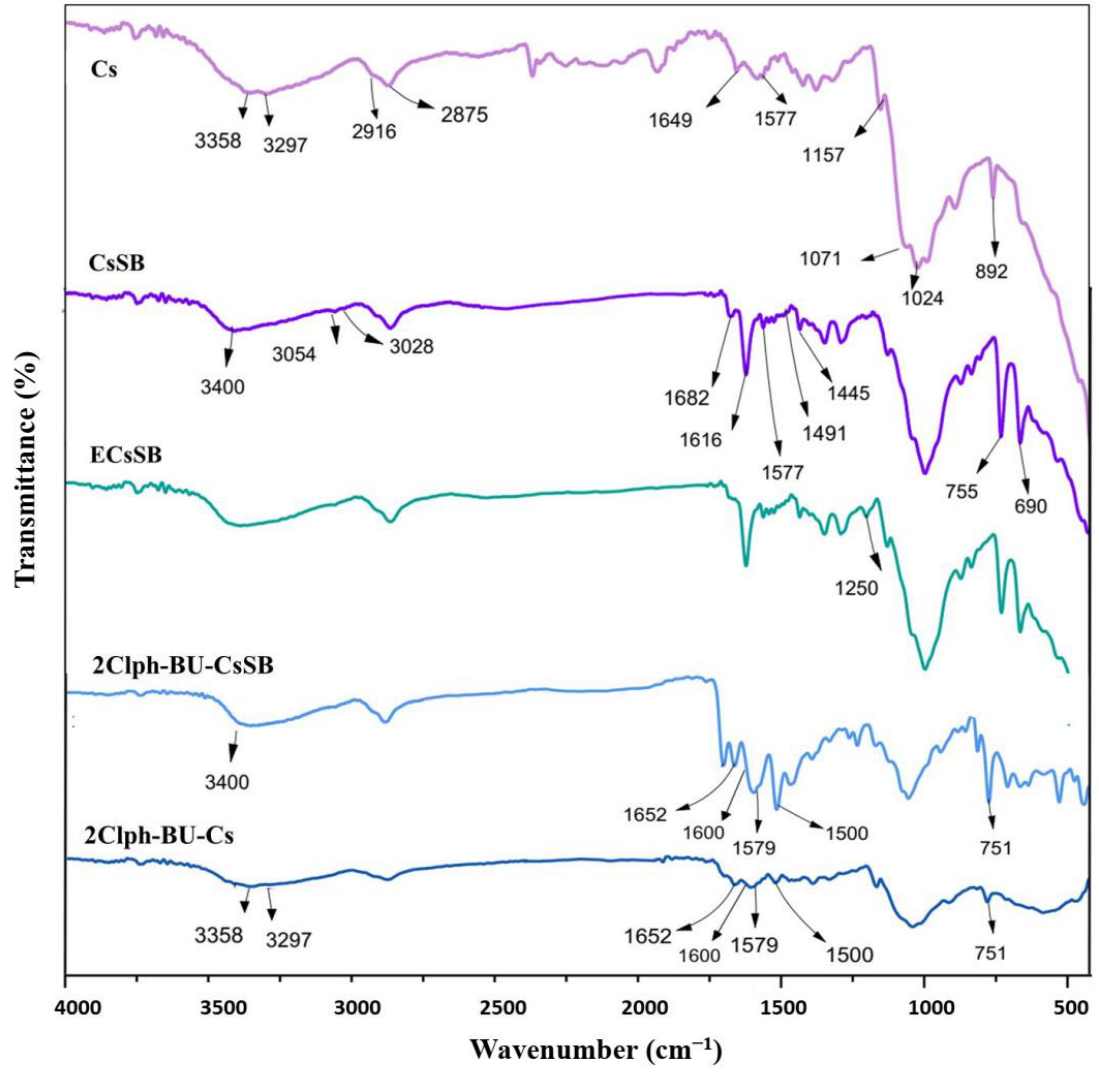
Figure 3. FTIR spectra of 2Clph-BU-CsSB and 2Clph-BU-Cs adsorbent.